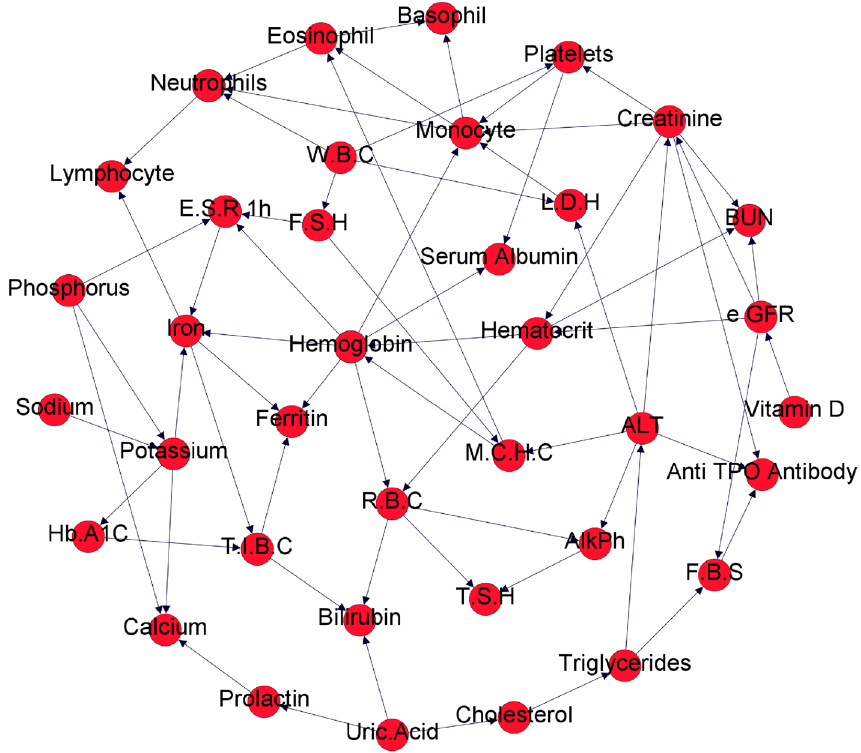
Figure 9. The structure of the blood test parameters inferred from routine blood test data.